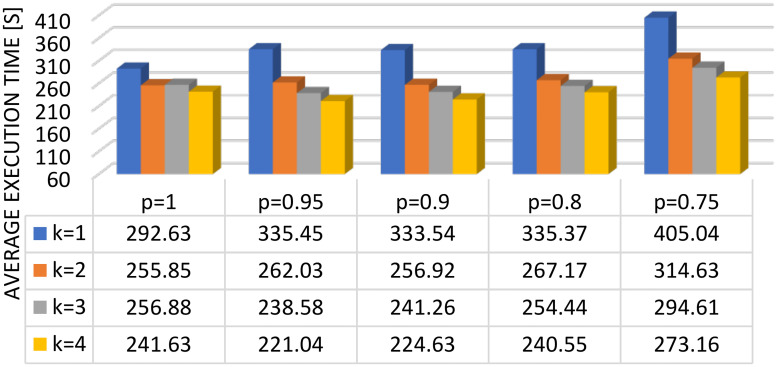
Summary of obtained average time of execution for different values of k and p.